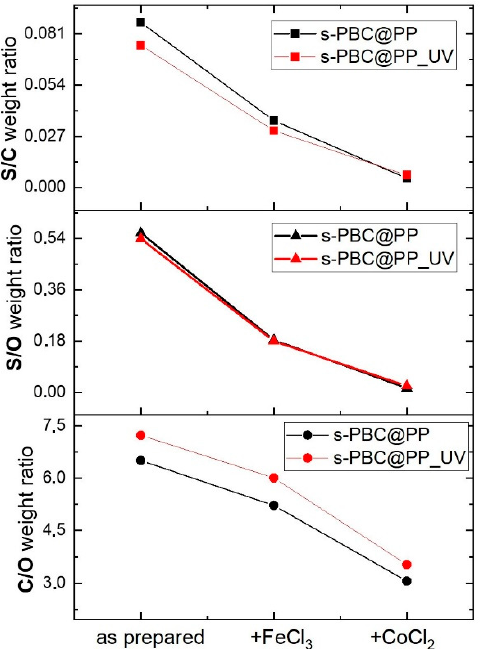
Figure 7. C/O, S/O, and S/C weight ratios measured by EDX analysis for s-PBC@PP and s- PBC@PP_UV samples before and after dipping in FeCl 3 solution or in CoCl 2 solution for 180 minutes.